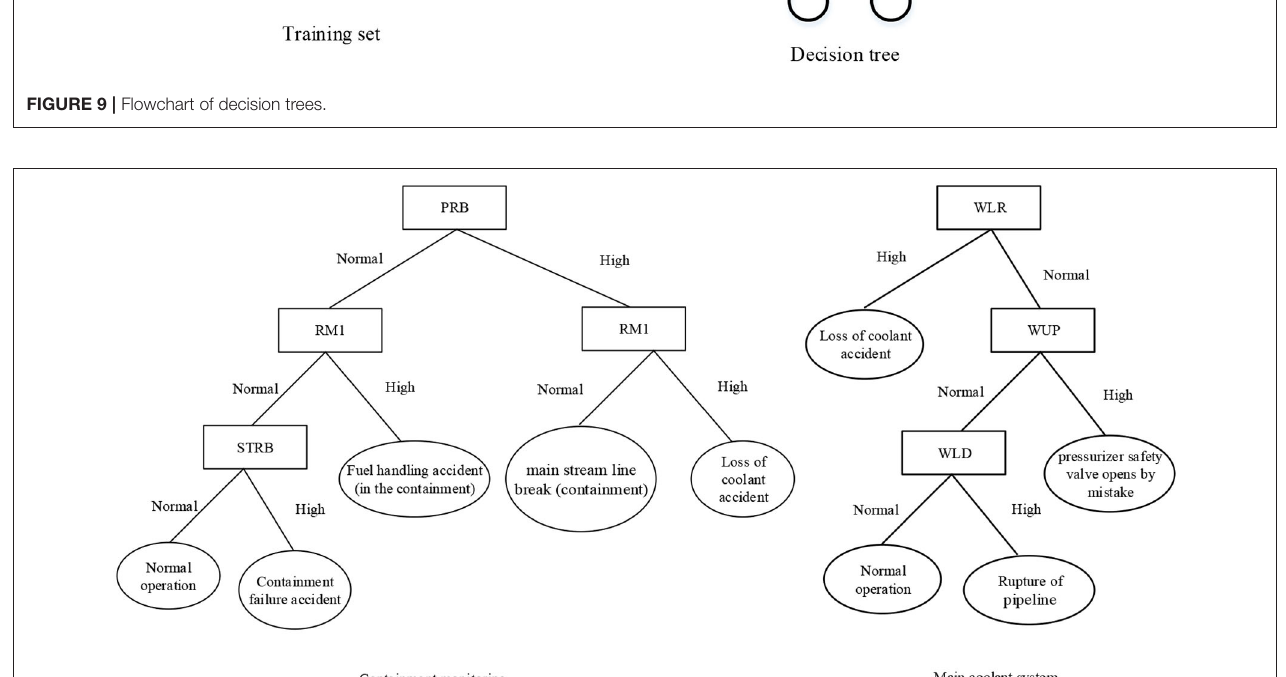
FIGURE 10 | Decision tree model of containment monitoring and the main coolant system (RM1, radioactivity level in the containment; PRB, pressure in the containment; WLR, the main coolant leakage flow rate; WUP, pressurizer safety valve flow; and WLD, lower leakage pipeline flow).